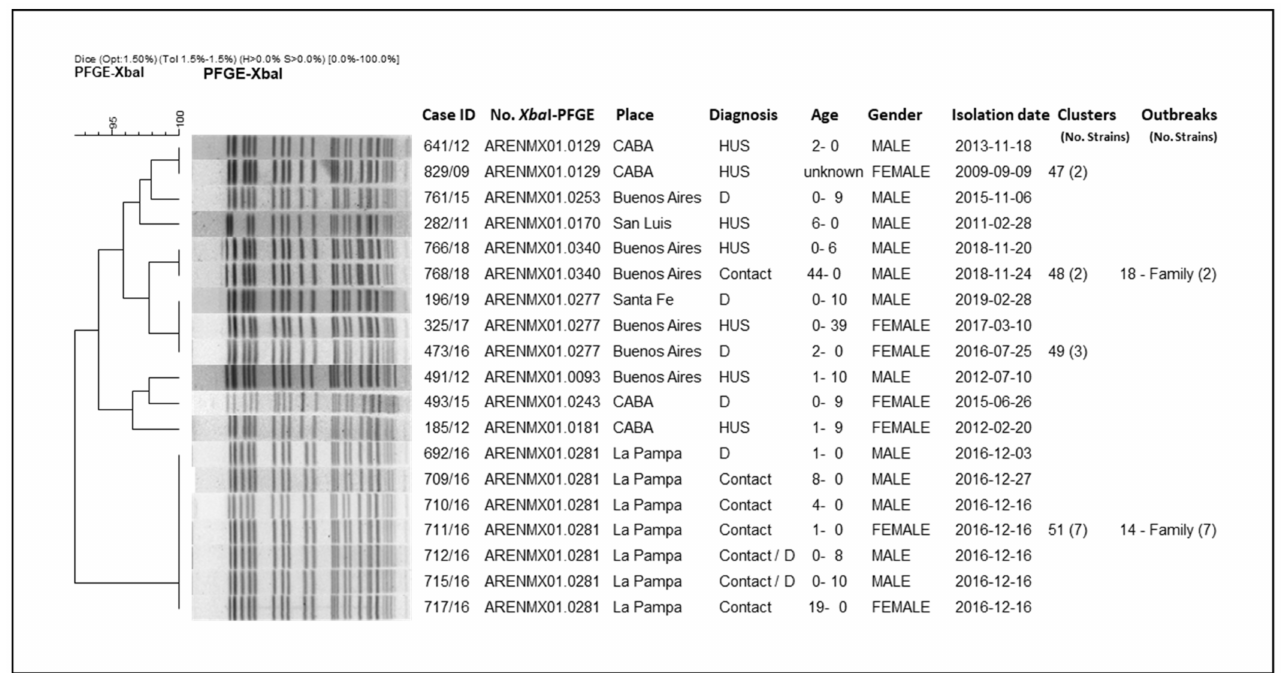
Figure 3. Clonal relatedness of different STEC O145 strains by Xba I-PFGE. City of Buenos Aires